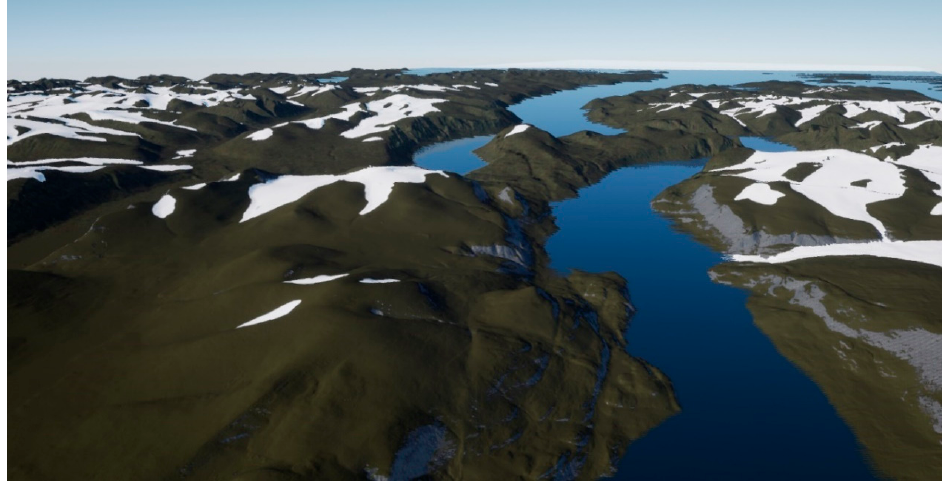
Figure 9. Landscape scenery in UE4 with natural terrestrial coloration. Even distant landscape parts are visible.